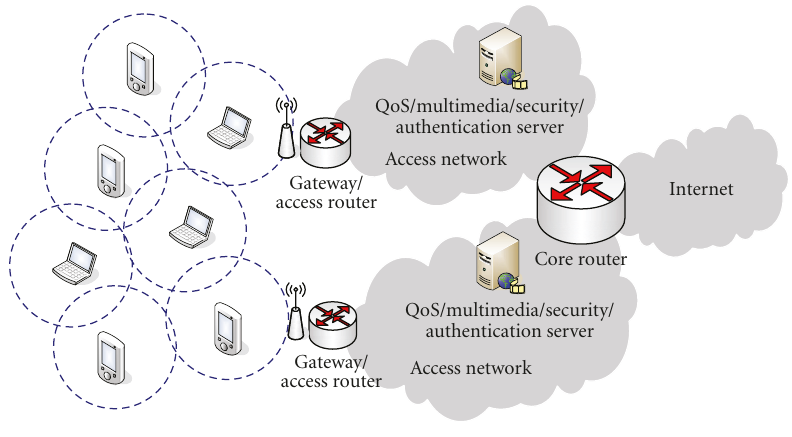
Figure 1: Extended hotspot